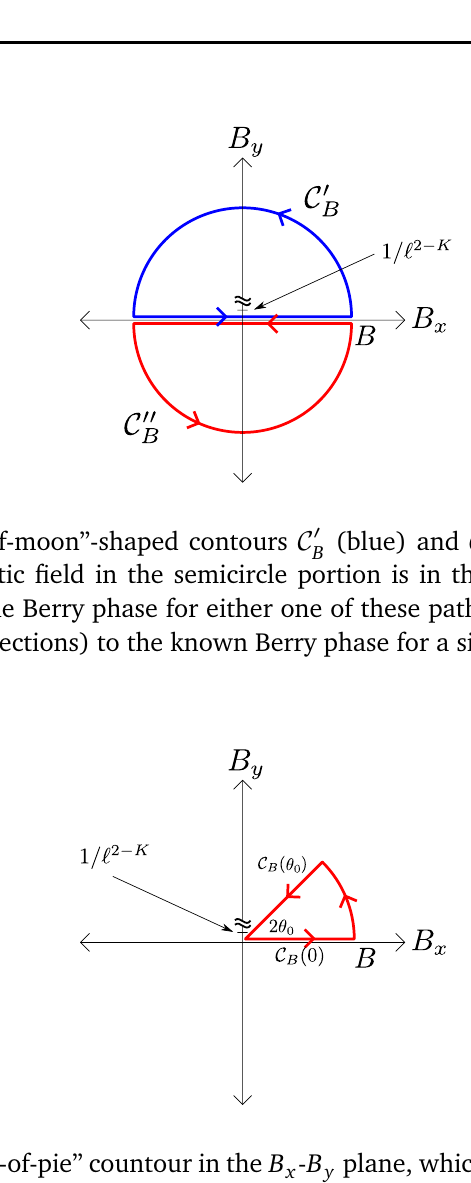
- B plane, which achieves a phase gate x y